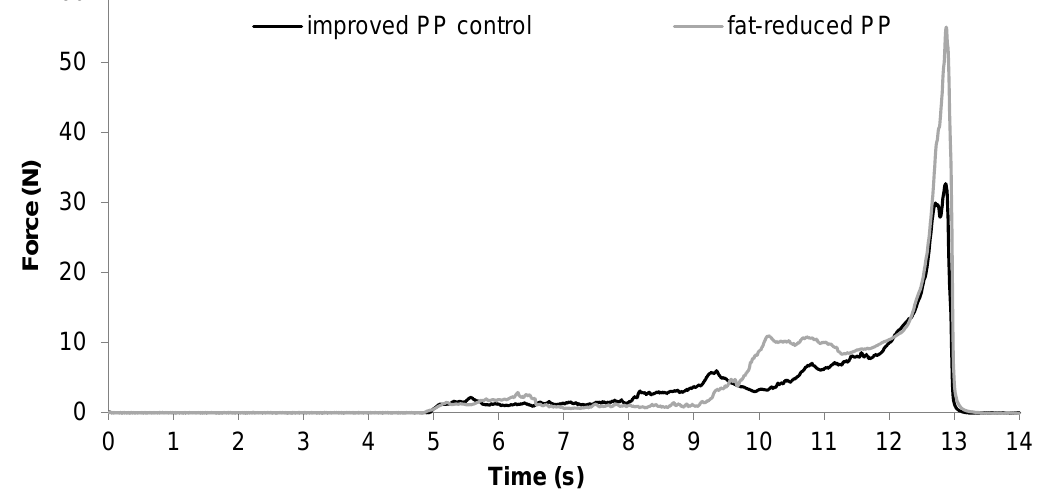
Figure 2. Force–time plot of 40% fat-reduced puff pastry (48 layers, 2.25 mm) and improved puff pastry control (81 layers, 2.50 mm).